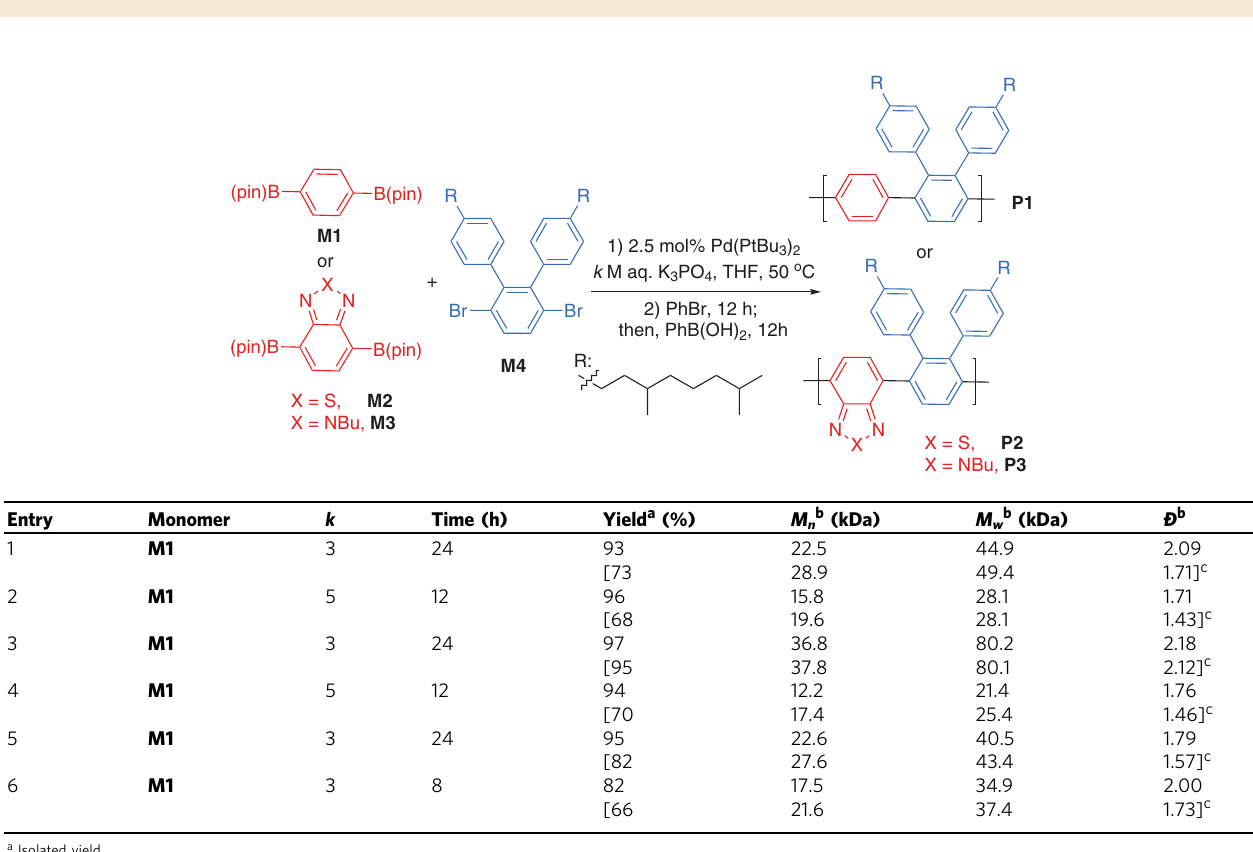
Table 1 Selected polymerization study to prepare GNR